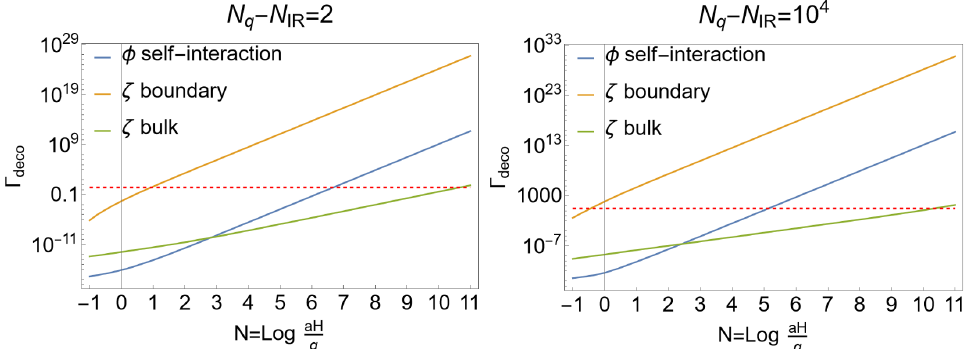
Figure 2 . The comparison between Γ ϕ , Γ bd ∆ N ≈ 2 and ∆ N ≈ 10 4 used in [25] respectively. The red-dashed line indicates the value Γ = 1 when the field starts to decohere, and N = log Since Γ bd = 1 around the horizon crossing, the full form of J ( Q, ∆ N ) (B.1) without making the ζ late-time expansion (4.14) is